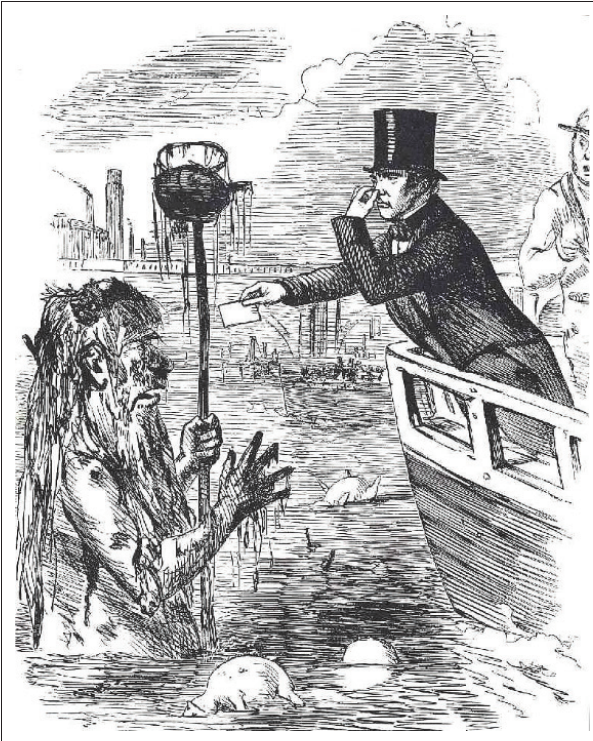
FIGURE 2: The scientist Michael Faraday presenting his business card to a stinking dirty Father